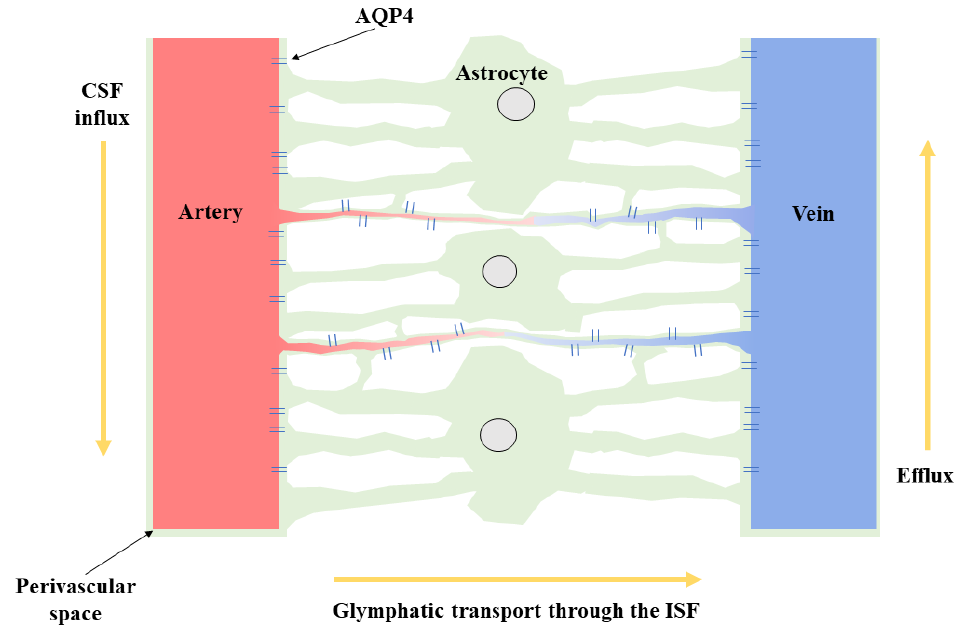
Figure 1. Glymphatic transport through the interstitial fluid (ISF). Nutrient transfer and waste clearance occur via the glymphatic system by utilising perivascular channels established by astroglia surrounding supplying. Here, the image depicts the vessels and surrounding aquaporin-4 (AQP4) water channels, that are highly expressed on astroglial end-feet, which regulate cerebrospinal fluid (CSF) flux in the direction of the arrow to be returned to the venous system. The exact mechanisms of this transport remain contentious (i.e., via cardiovascular pulsation or diffusion etc).